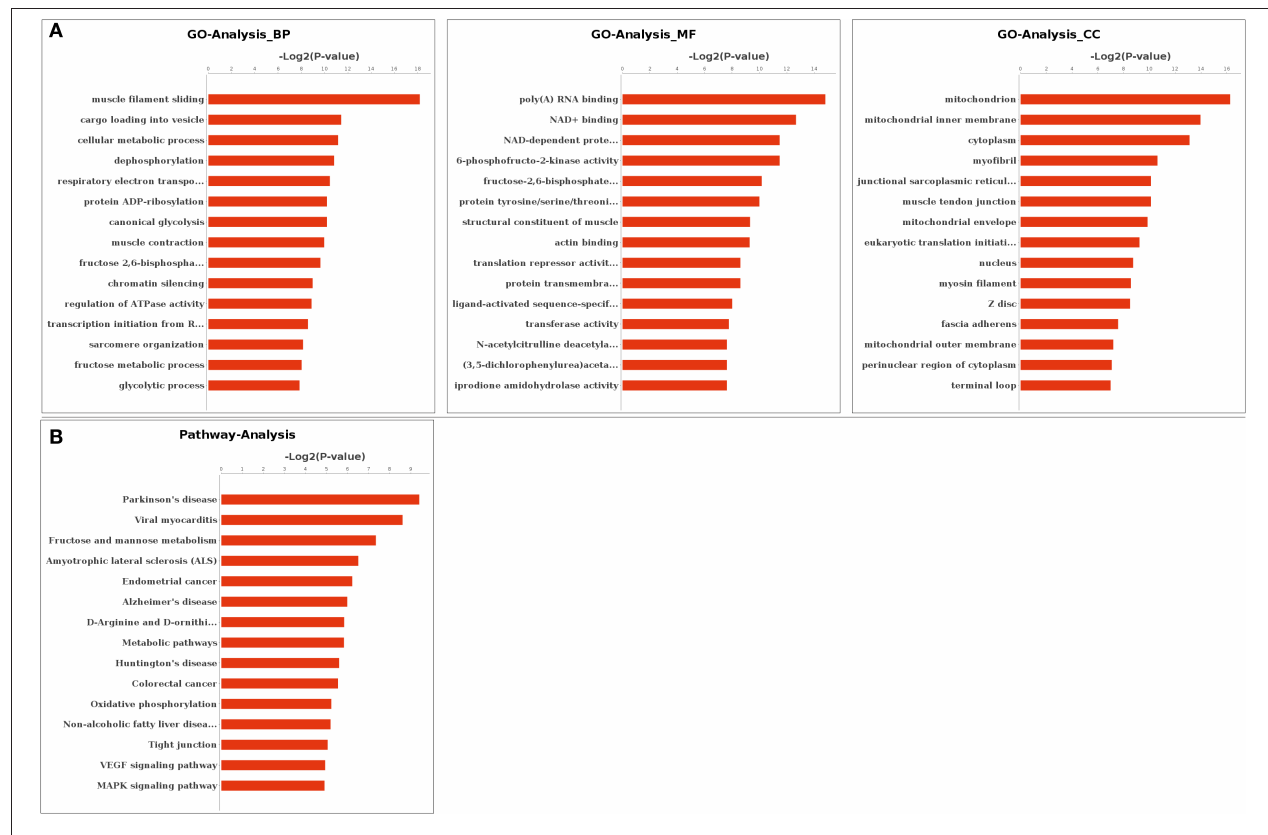
FIGURE 3 | Gene Ontology (GO) and Kyoto Encyclopedia of Genes and Genomes (KEGG) enrichment. (A) GO enrichment of differentially expressed genes. (B) KEGG enrichment of differentially expressed genes. BP, biological processes; MF, molecular functions; CC, cellular